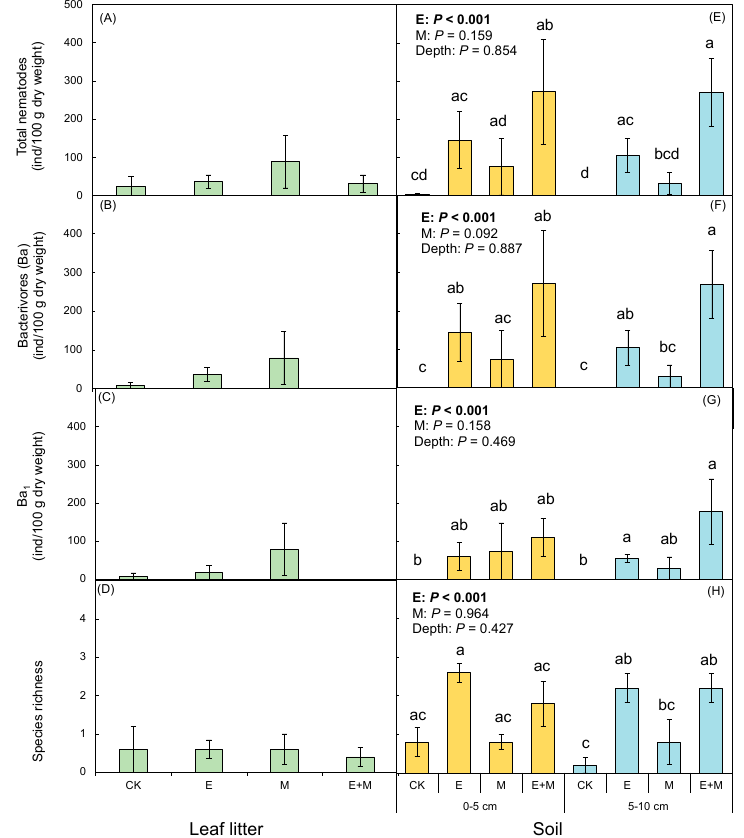
Figure 2. Abundances and species richness of nematodes in the leaf litter and soil, as affected by earthworms and millipedes. ( A , E ) Total nematodes abundance; ( B , F ) the abundance of bacterivores; ( C , G ) the abundance of Ba 1 guild of the bacterivores; ( D , H ) number of the nematode species. Data represent means ± SE (n = 5). Signi fi cant ( p < 0.05) e ff ects based on one-way ANOVA are presented by lowercase le tt ers. Table 2. E ff ects of earthworm addition (E) and millipede addition (M) on nematodes in leaf li tt er.